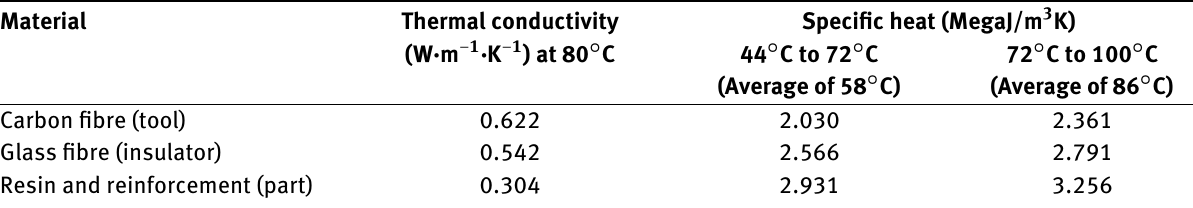
Table 2: Thermal conductivity and specific heat results for the tooling prepreg and the part